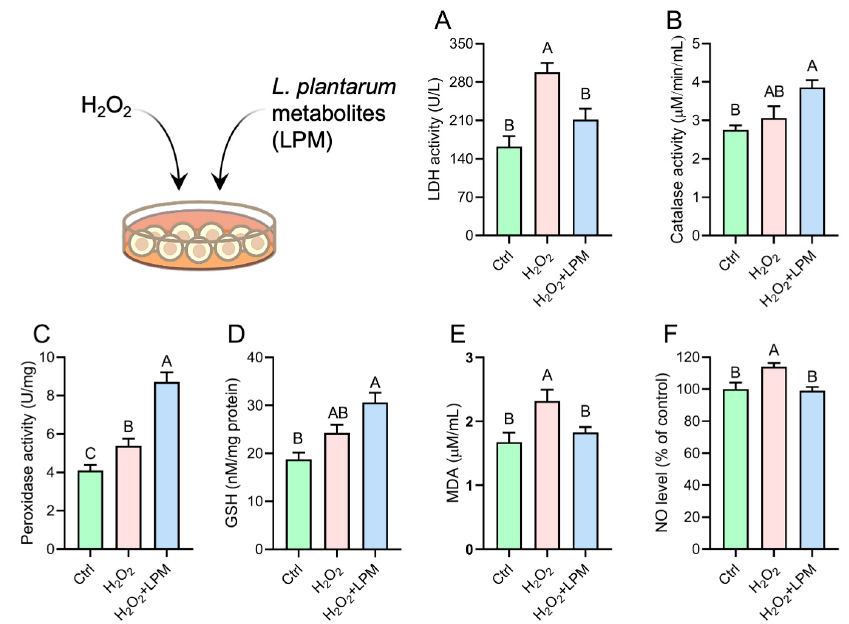
Figure 5. Effects of L. plantarum metabolites (LPM) on the ( A ) lactate dehydrogenase (LDH) leakage, ( B ) catalase activity; ( C ) peroxidase activity; ( D ) glutathione level; ( E ) malondialdehyde (MDA) release; and ( F ) nitric oxide (NO) release in HepG2 cells that were treated with hydrogen peroxide (H 2 O 2 ). Data represented as mean ± SEM of 3 measurements. Groups not sharing a common letter are significantly different ( p ≤ 0.05).